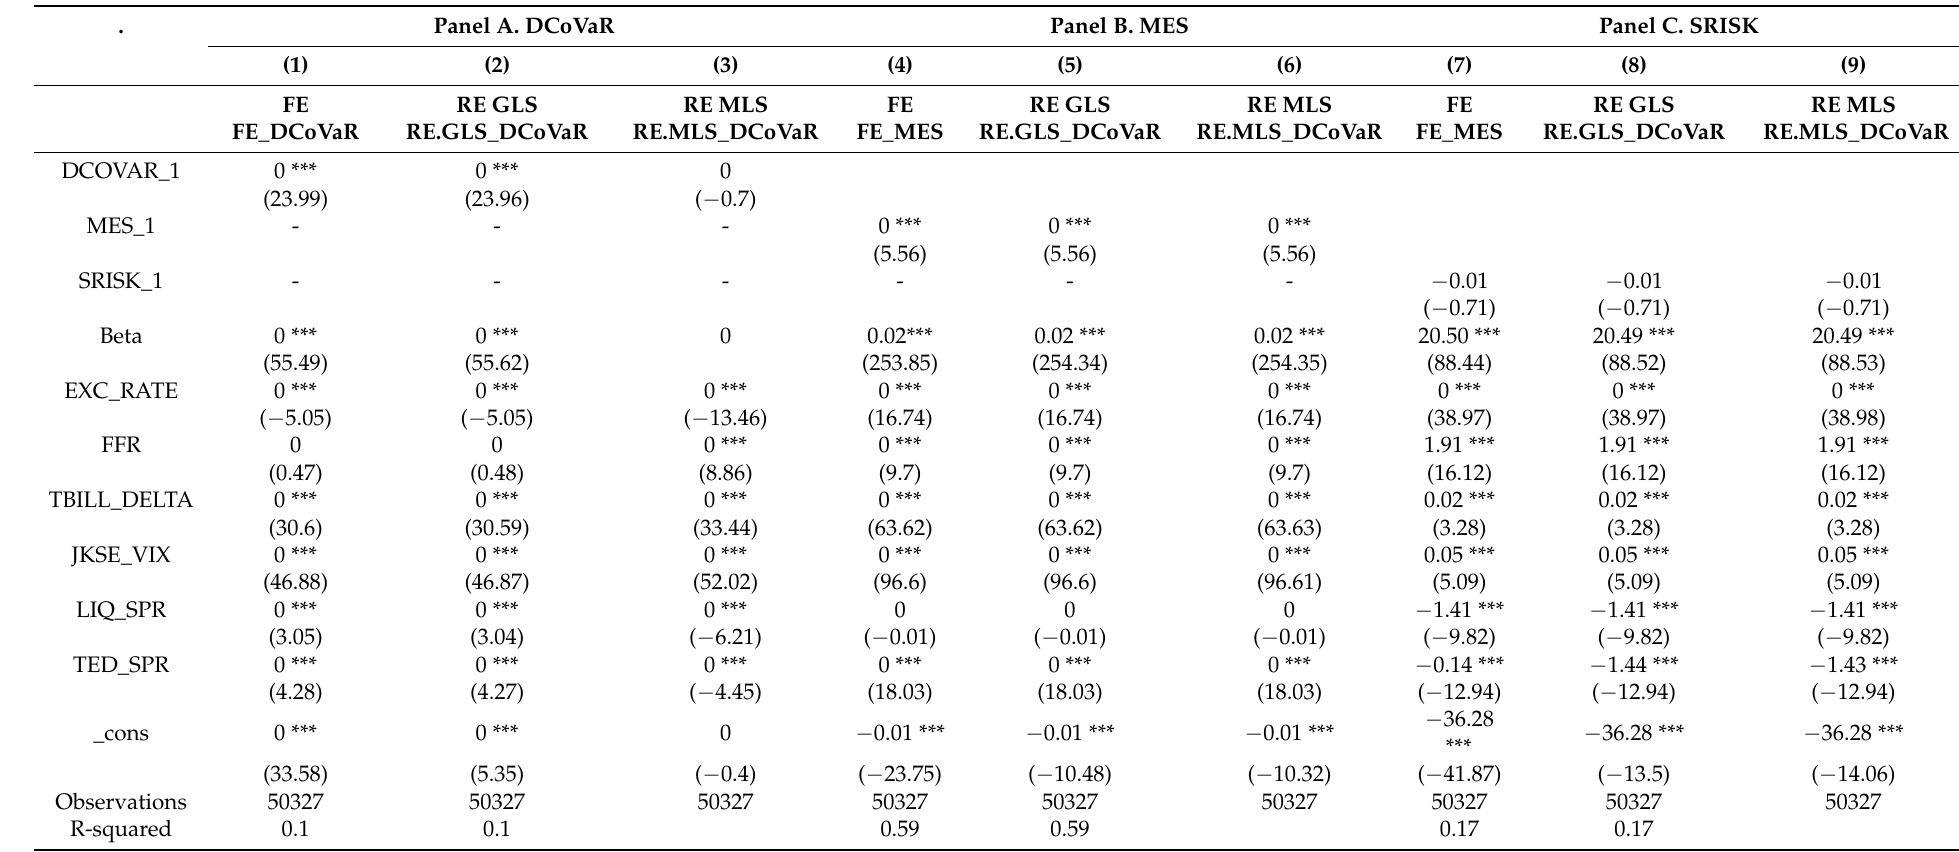
Table 9. Fixed and Mixed Effect Results